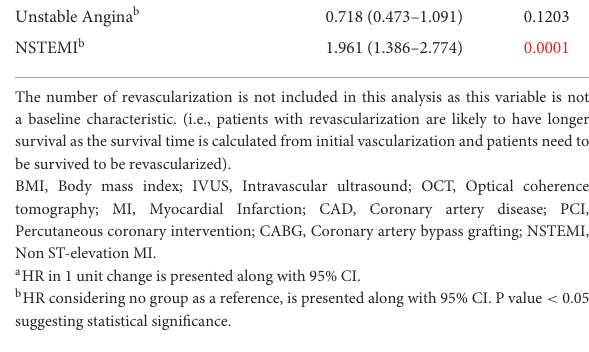
TABLE 3 Multivariate Cox model (on overall survival